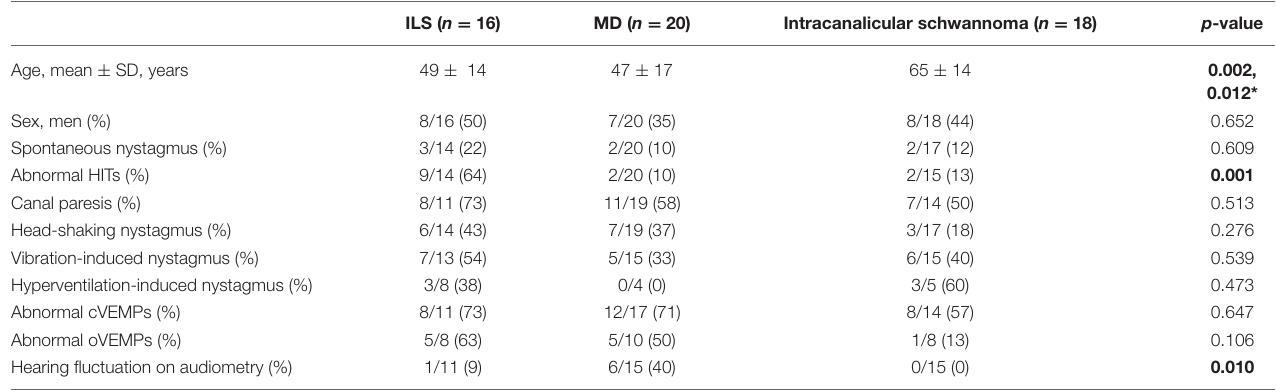
TABLE 2 | Neurotologic findings in patients intralabyrinthine schwannoma (ILS) and Meniere’s disease (MD). ILS ( n = 16) MD ( n = 20) Intracanalicular schwannoma ( n = 18) p